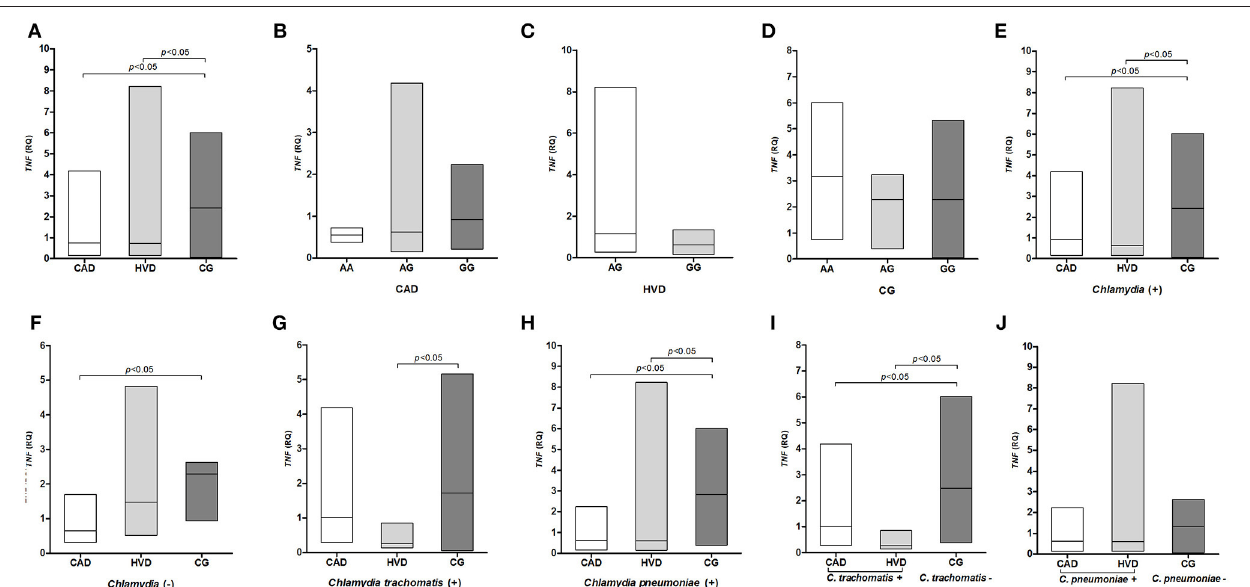
FIGURE 3 | Distribution of TNF mRNA levels (A) between patients receiving surgical revascularization for coronary artery disease (CAD), patients undergoing valve replacement for heart valve disease (HVD) and control subjects (CG); (B–D) according to the different TNF - 308G > A genotypes; (E) among groups serologically positive and (F) negative for Chlamydia ; (G,I) among groups with and without previous exposure to C. trachomatis and (H,J) to C. pneumoniae .